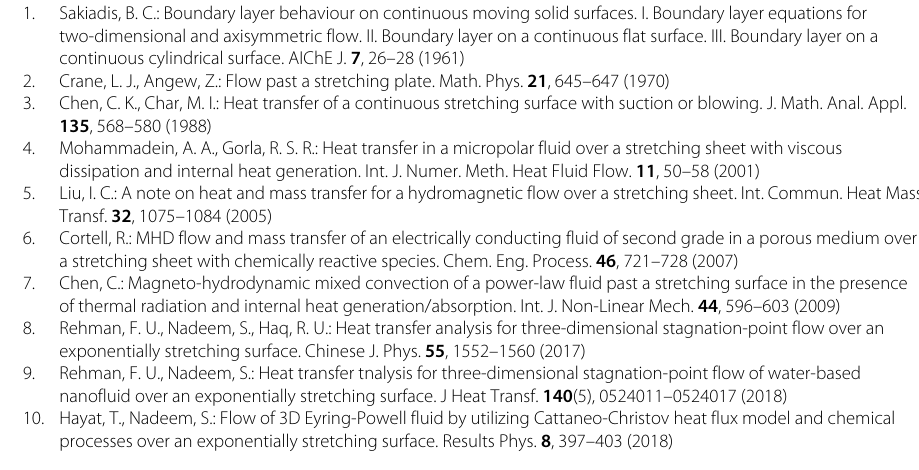
1 2 x Cf x and Re Table 2 Values of 1 Re 2 m = 1 , r = 2 , Pr = 3 3